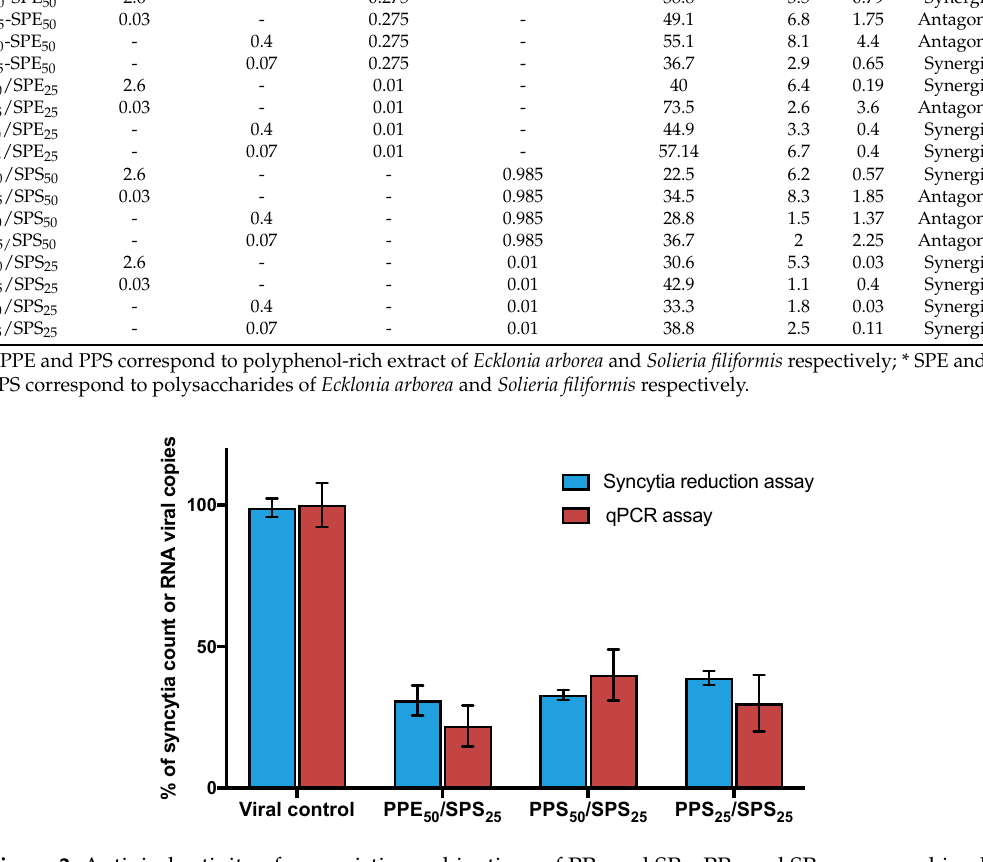
Figure 2. Antiviral activity of synergistic combinations of PPs and SPs. PPs and SPs were combined with their IC 25% and IC 50% and the antiviral effect was determined by syncytia reduction and qPCR assays. Syncytia count and viral RNA copies number are given in % of the untreated control values. Each bar represents the average of three replicates. Table 3. Combined antiviral effect of PPs of Ecklonia arborea and Solieria filiformis with ribavirin.